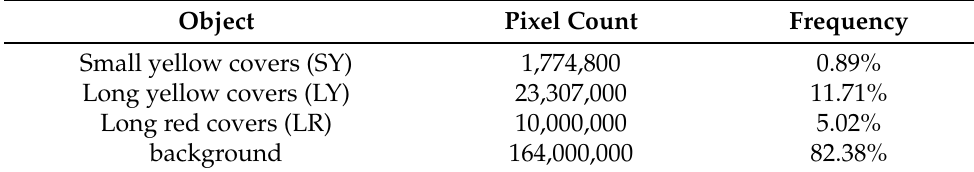
Table 2. Pixel count per object in the